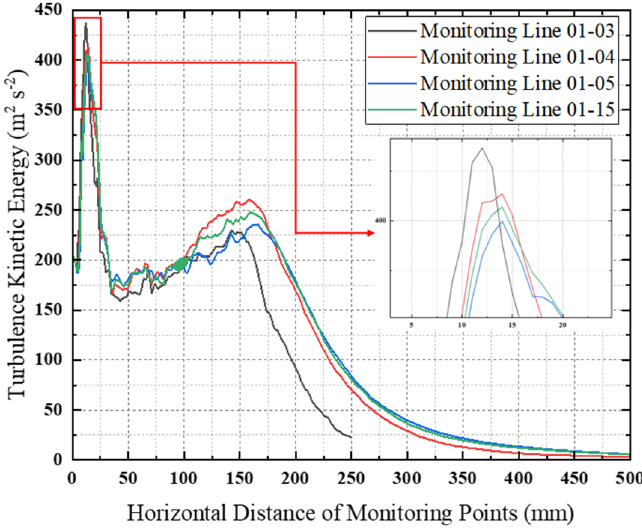
Figure 8. Line graph of the turbulent kinetic energy of the equal-diameter nozzle flow field with a compressed air pressure of 212,782 Pa and a temperature of 303